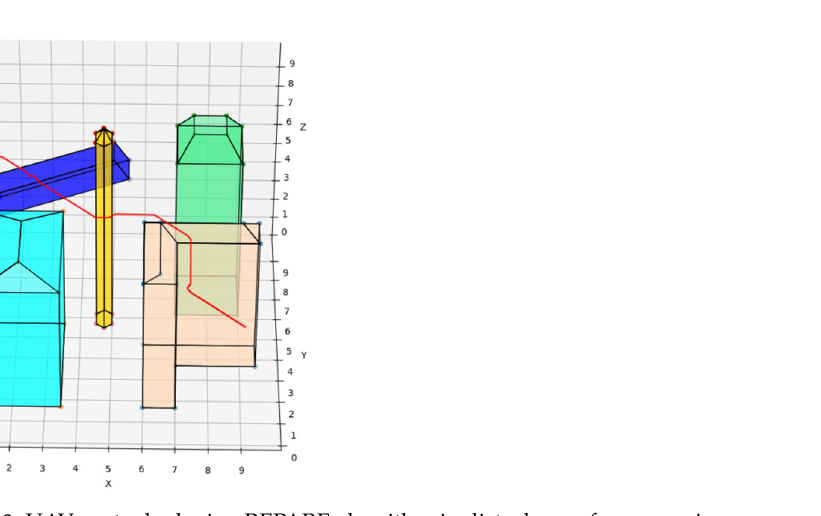
Figure 9. UAV route deploying traditional artificial potential field route planning algorithms in dis- turbance-free scenarios.